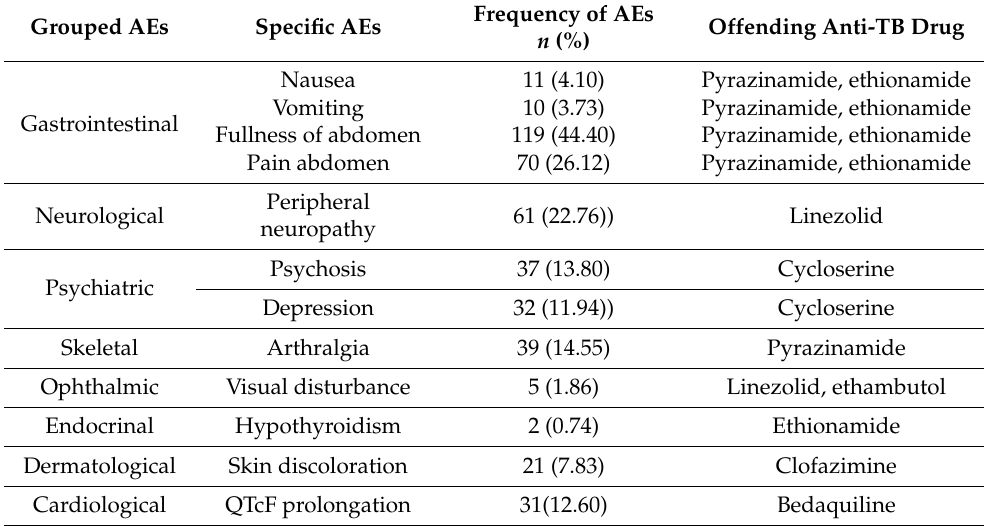
Table 4. Frequency of adverse events (AEs) among drug-resistant pulmonary tuberculosis patients ( n =